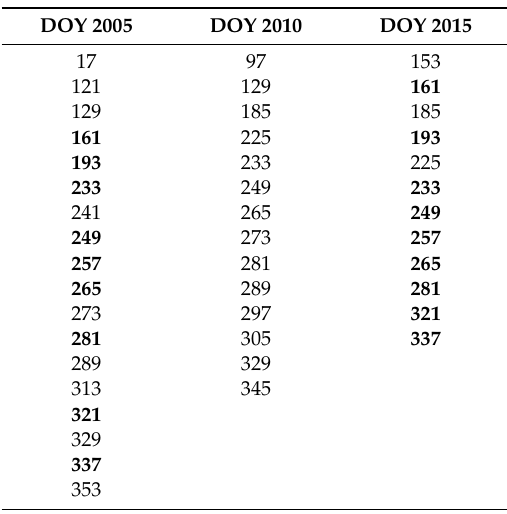
Table 5. The Day of the Year (DOY) for the MODIS satellite images with at least 90% cloud-free overpass over the Kilombero Valley (KV) river basin for the years 2005 (DOY 2005), 2010 (DOY 2010), and 2015 (DOY 2015). Common DOY for 2005 (five years before implementation of SAGCOT initiative) and 2015 (five years after the implementation of SAGCOT initiative) are shown in bolded font. SAGCOT, Southern Agricultural Corridor of